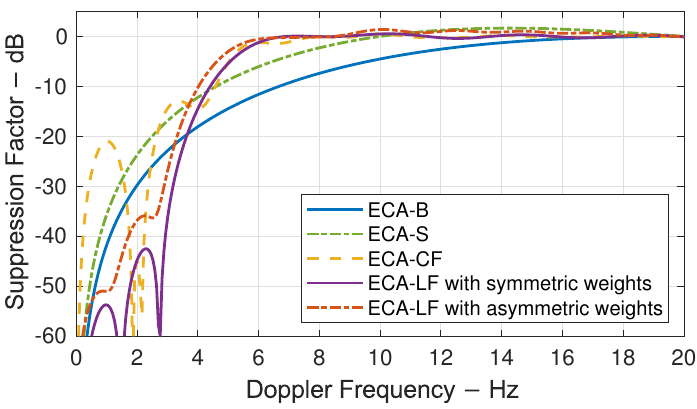
Figure 4. Suppression performance of different ECA